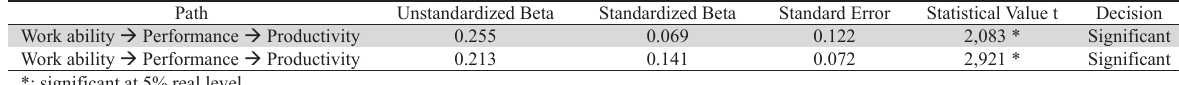
Results of the Regression Weight Indirect Effect